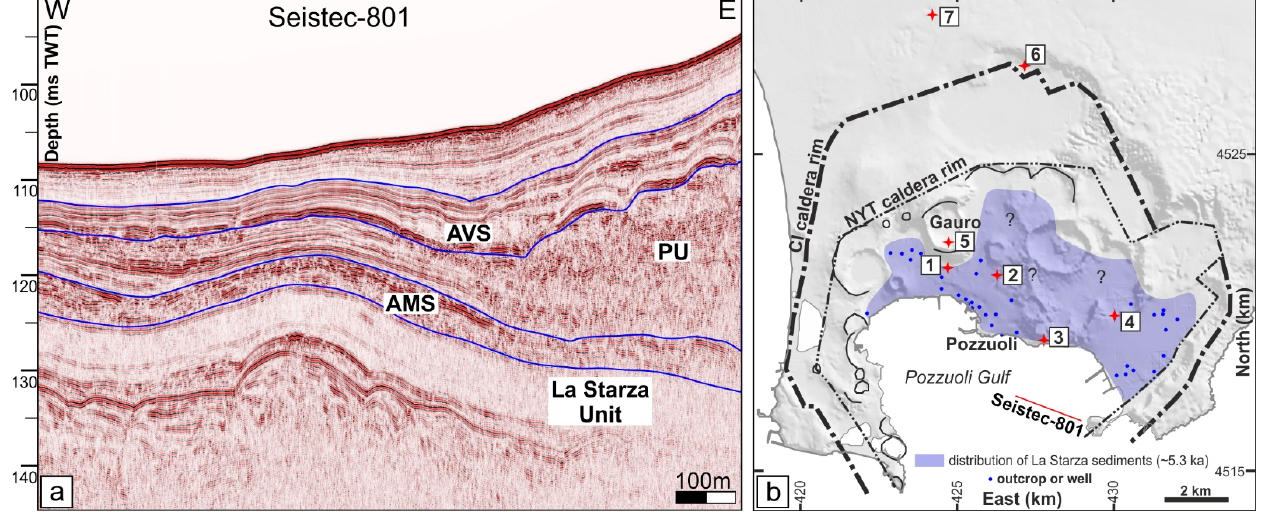
Figure 7. ( a ) Interpreted seismic profile within the Pozzuoli Gulf (after [47] modified). ( b ) Recon- struction of the La Starza sediment distribution (after [19] modified). AMS: Agnano–Monte Spina; PU: Pozzuoli Unit; AVS: Averno-Solfatara.